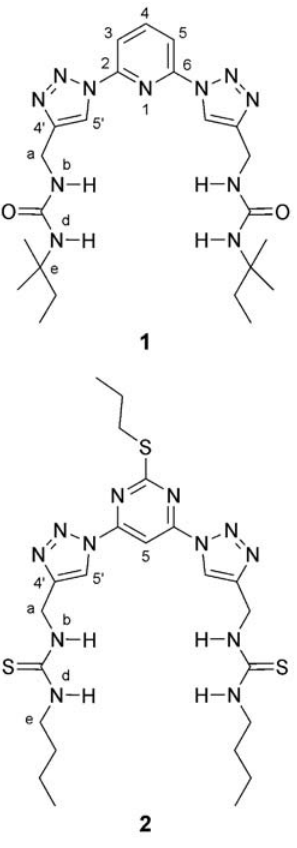
Figure 1. Anion receptors 1 and 2 with atom numbering.